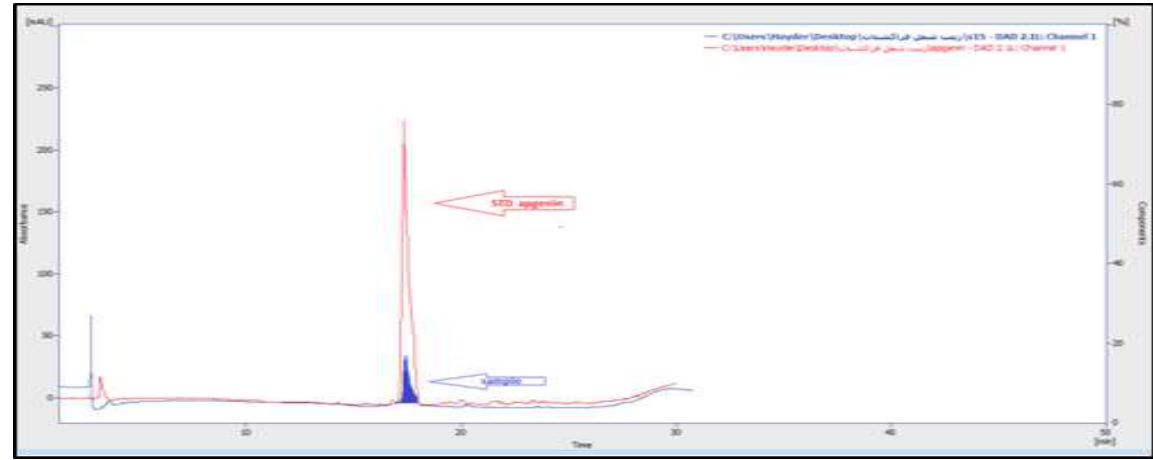
Figure 5.Analytic apigenin standard and isolated compound